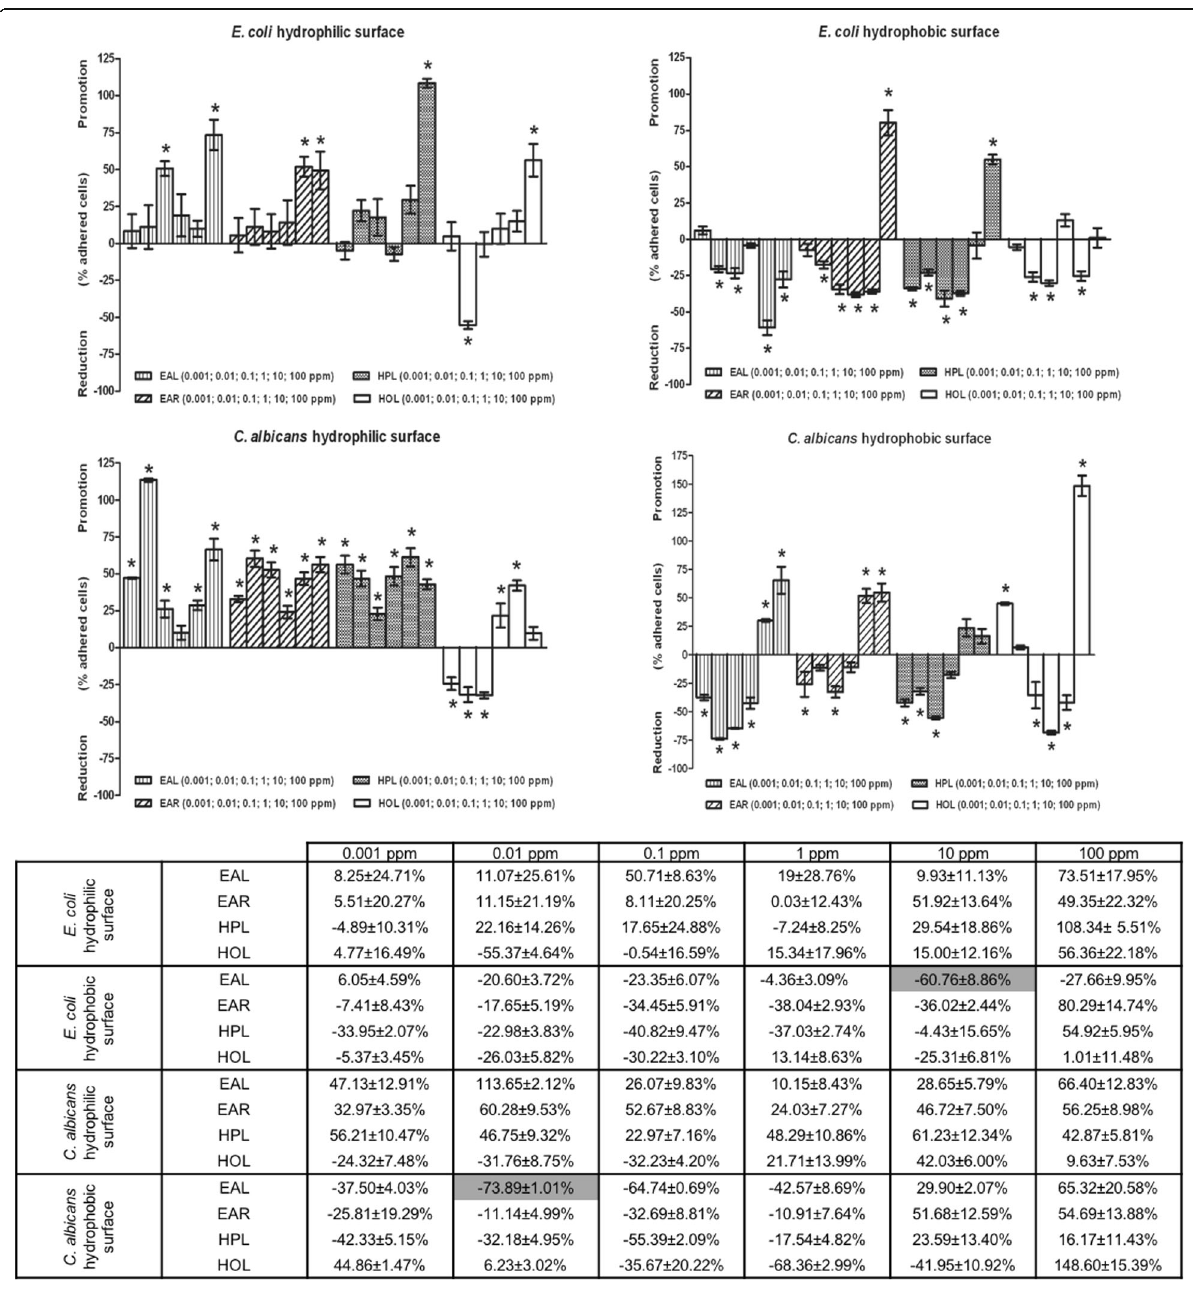
Fig. 6 Microplate-based biofilm assay. Percentage reduction of the number of adhered cells of E. coli and C. albicans on hydrophilic and hydrophobic surface in presence of non-lethal concentrations of seagrass extracts. According to post hoc analysis (Tukey ’ s HSD, p ≤ 0.05), stars indicate statistically significant differences between the means of three independent replicates. In addition, the mean ± SDs of the percentage reduction of the number of adhered cells with seagrass extracts at non-lethal concentrations on hydrophilic and hydrophobic surface are reported in the table. The higher anti-adhesion effect for each microorganism was highlighted. (EAL = Enhalus acoroides leaf; EAR = Enhalus acoroides root; HPL = Halodule pinifolia leaf; HOL = Halophila ovalis